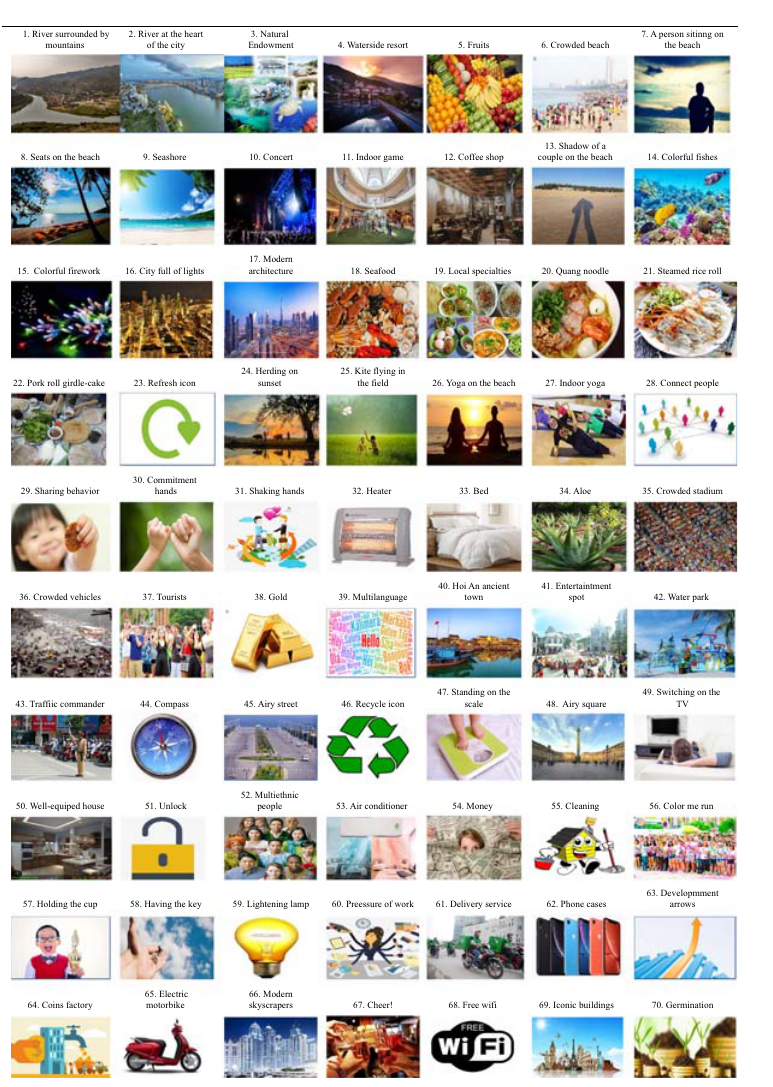
Figure A1. Metaphor Images of the critical